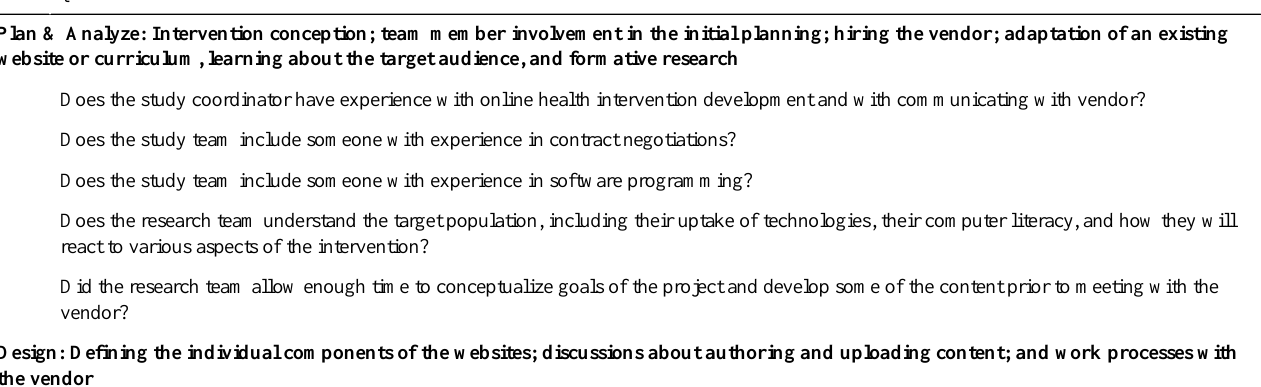
Table 3. Key questions to consider in phases of the development process for online health interventions.